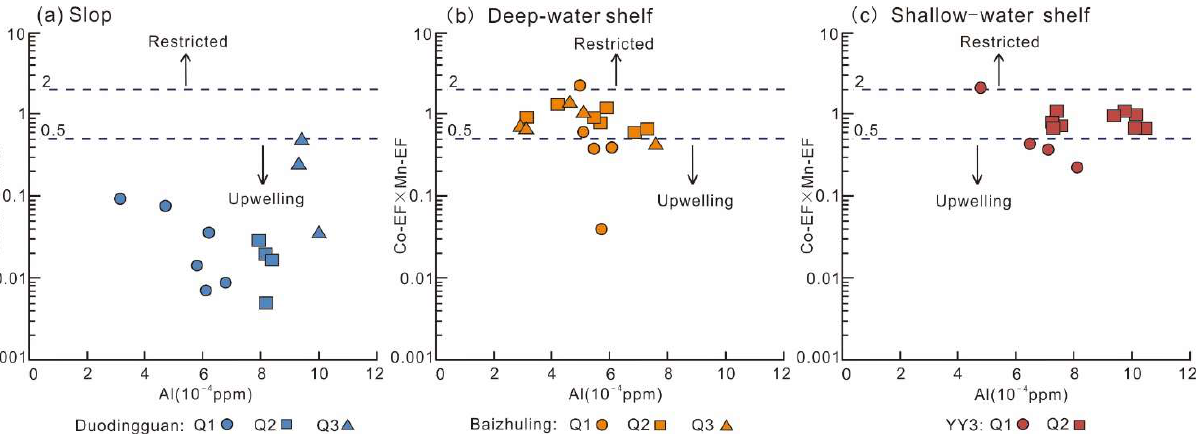
Figure 5. The relationship between Mo and TOC in the different zones during the deposition of the Qiongzhusi Formation in the study area after exclusion of data from the oxygen-rich environment. The Mo/TOC data for the four modern basins are from [35].